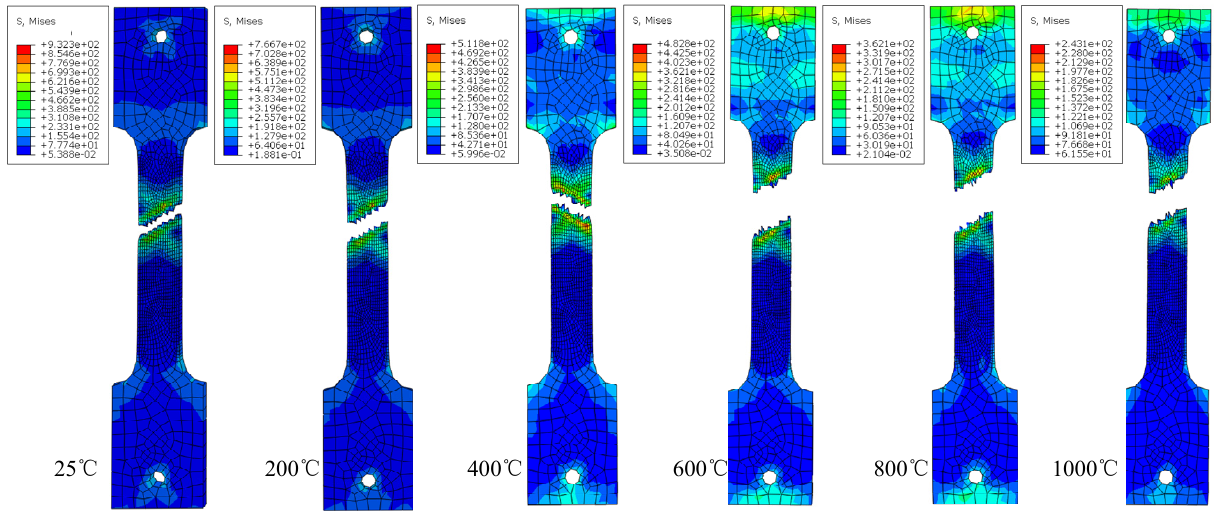
Figure 10. 316L high temperature tensile test simulation cloud diagram.